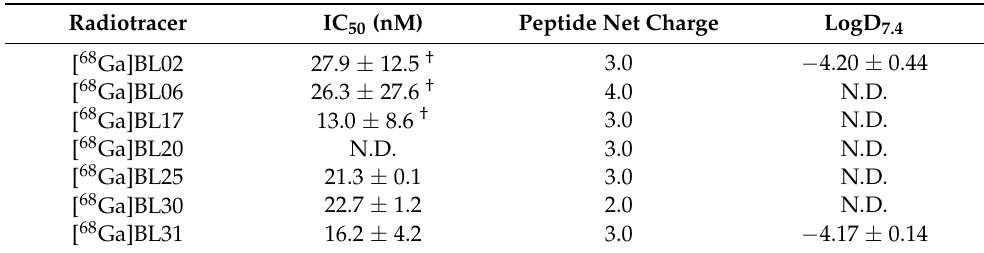
Table 1. In vitro data of each 68 Ga-labeled radiotracer. Peptide net charge was calculated at pH 7.40. All values are in triplicate, unless indicated